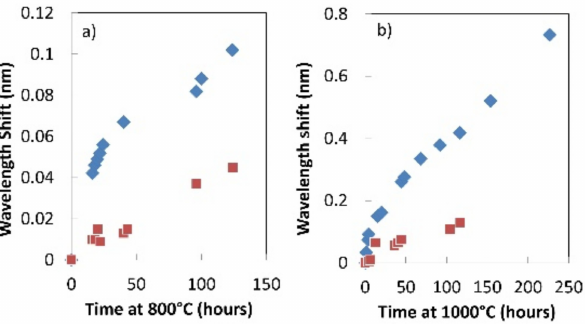
Figure 12. Bragg wavelength drift of Type II FBGs in SMF-28 (red) and RALF (blue) at 800 ◦ C ( a ) and 1000 ◦ C ( b ) (reproduced from [57]).